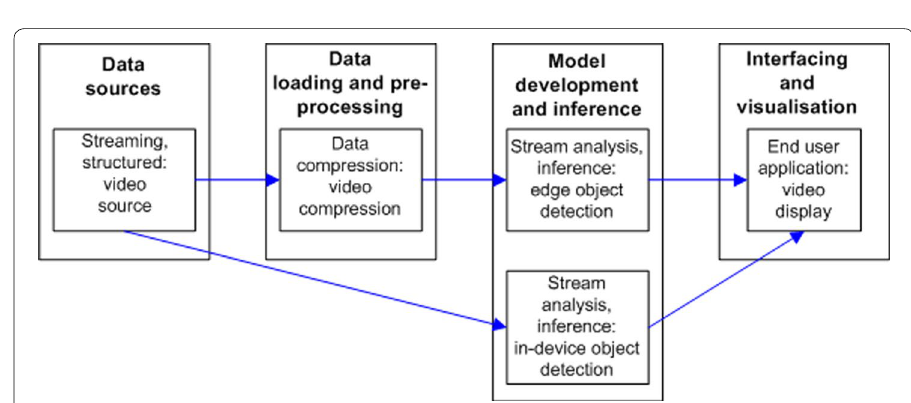
Fig. 8 The mapping of DeepDecision architecture [34] to the big data